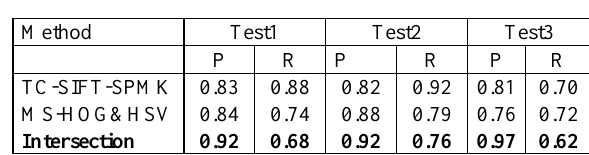
Table 3. Accuracy of HOG Feature methods